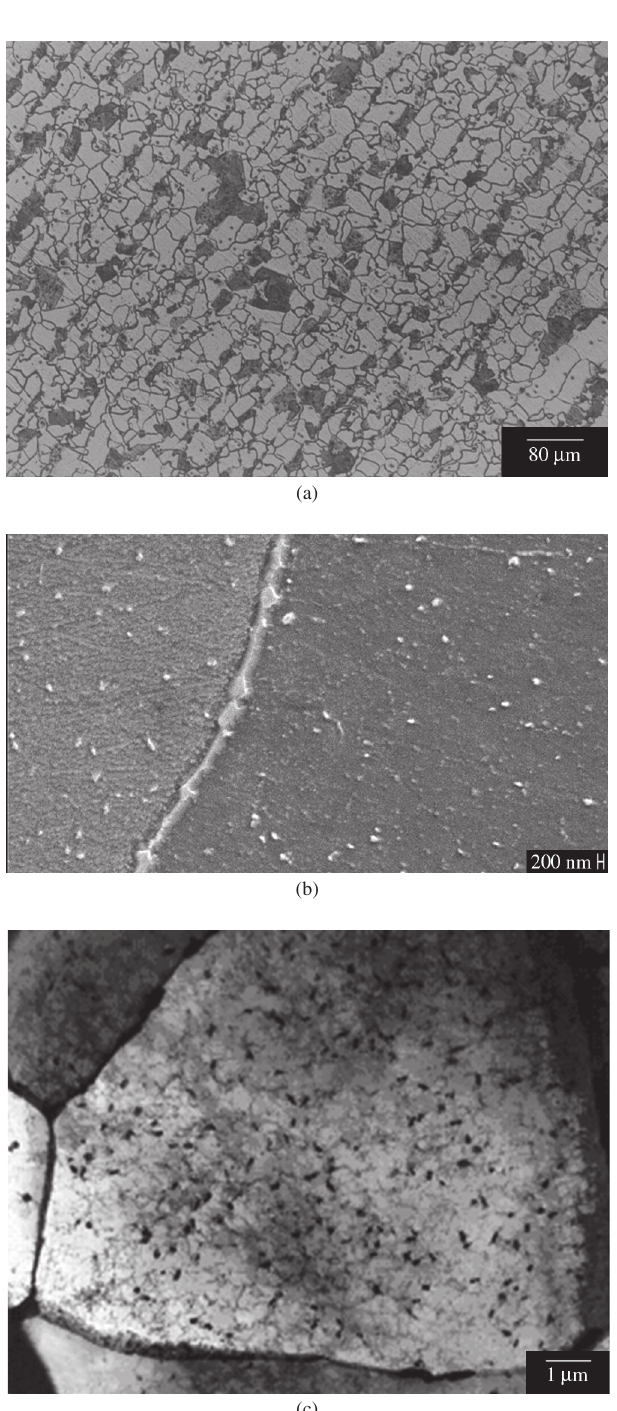
Figure 2. a) Optical microscopy image showing the ferrite-pearlite structure; and b,c) SEM and TEM images showing the fine intragranular and coarse inter- granular precipitation in the ISAM condition (cross-section of the pipe).